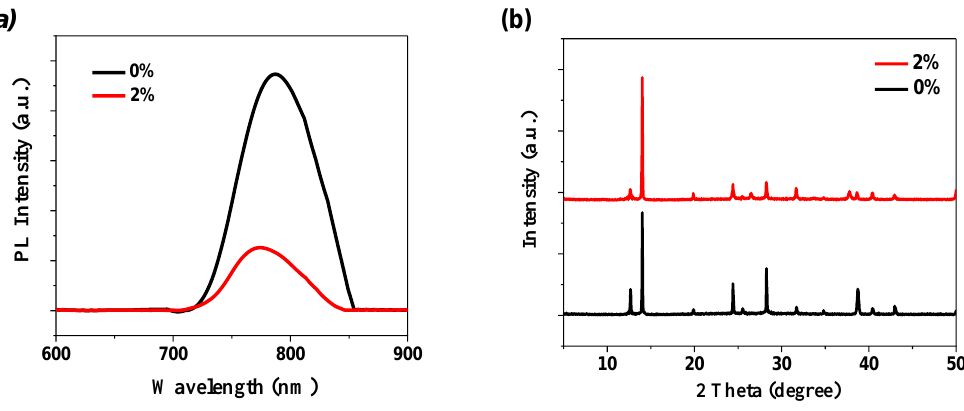
Figure 3: (a) Steady-state PL spectra and (b) XRD patterns of perovskite films deposited on 0% and 4% rGO/Bi O additives. 2 3